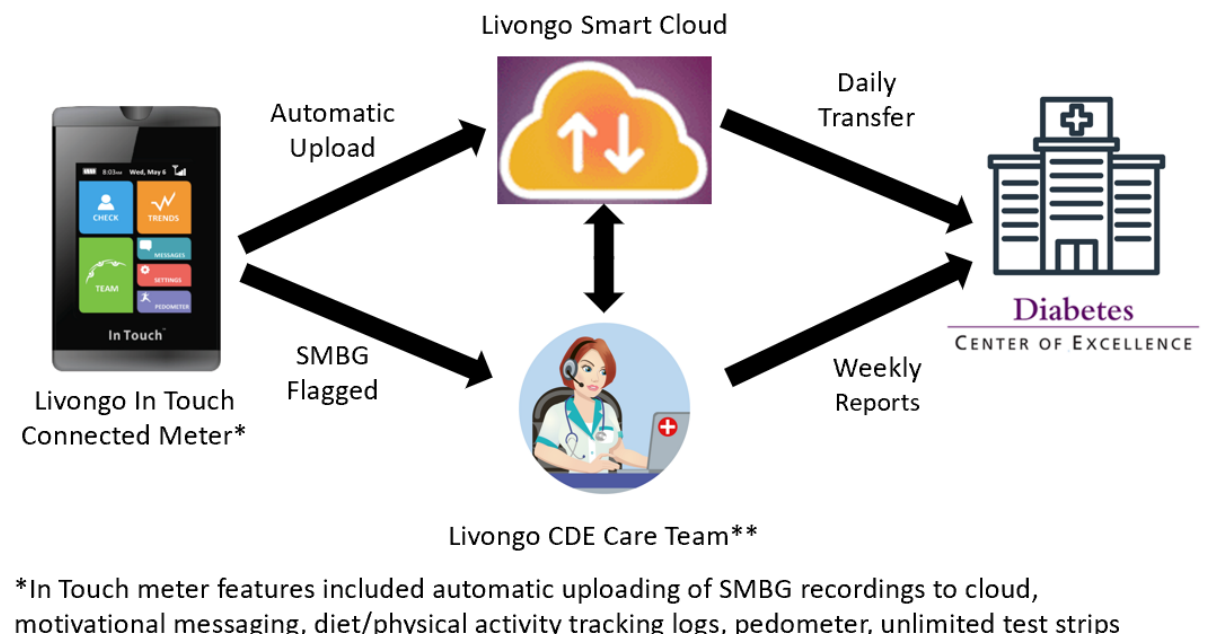
Figure 1. Intervention components and flow of patient data. CDE: Certified Diabetes Educator; SMBG: self-monitoring of blood